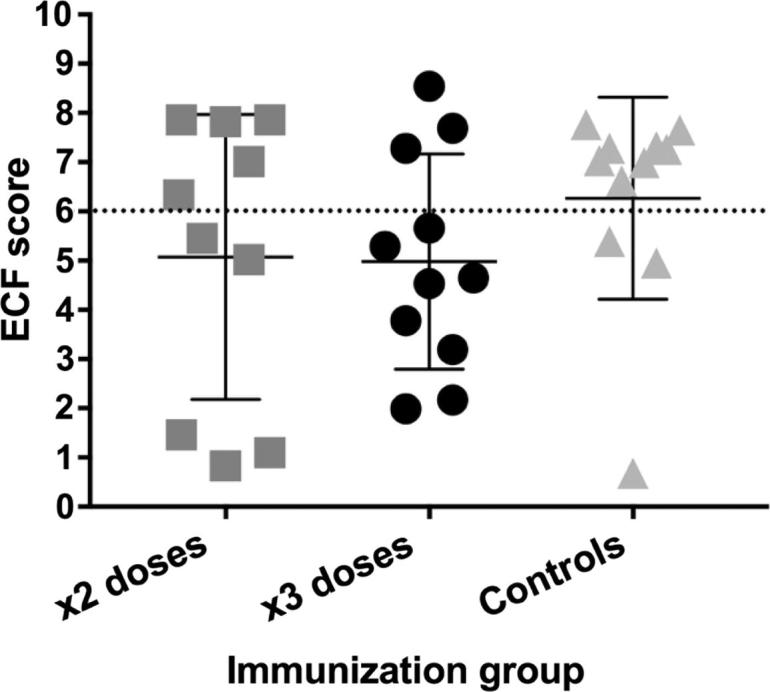
Immunity of cattle to ECF following sporozoite challenge. Animals are plotted individually and separated in groups: Group 1, two doses (grey squares), Group 2, three doses (black dots) and control animals (grey triangles). The mean of each group and the standard deviation is also shown. A cut off line separating immune (ECF score ≤ 5.99) and susceptible animals (ECF score ≥ 6) is shown as a black dotted line.